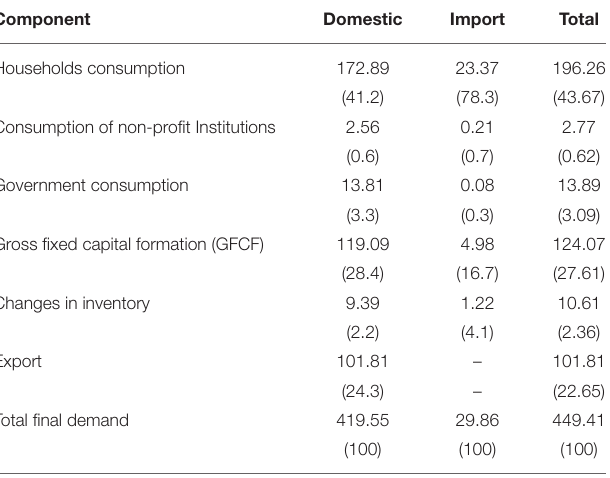
TABLE 2 | Environmental cost from emission due to final demand in Indonesia (Trillion Rp).